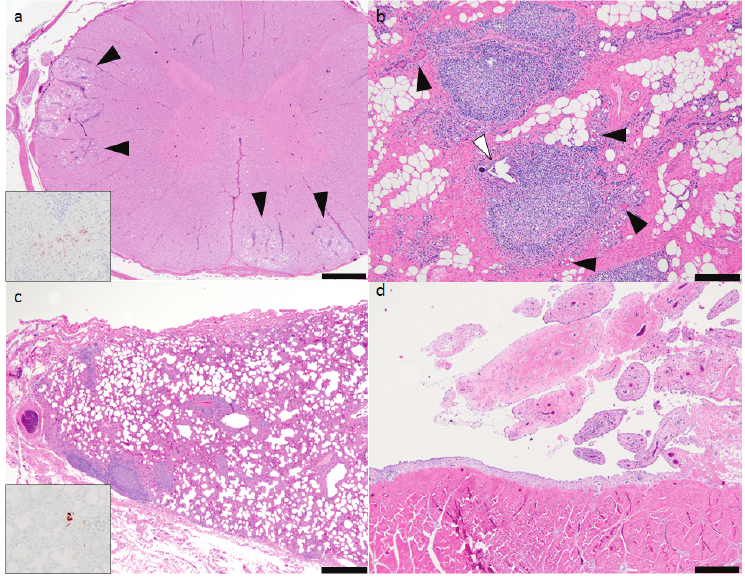
(SRLV) infection. ( a ) Ovine spinal cord, scattered foci of spongiosis within the white matter with multifocal mixed mononuclear inflammatory cell infiltrations (black arrowheads). Hematoxylin and eosin stained histologic sections, 20× magnification.